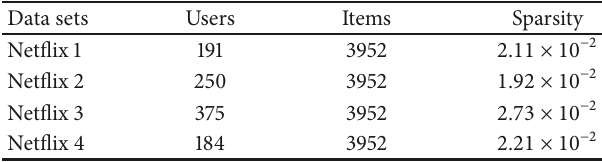
Table 2: Properties of the Netflix data sets.